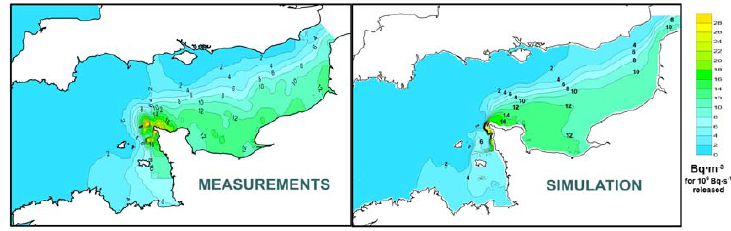
Figure 13. Normalized measured and Lagrangian residual simulated distribution of 125 Sb between 1983 and 1994 for a constant release of 10 6 Bq ∙ s − 1 , adapted from [20]. Water 2020 , 12 , 1667